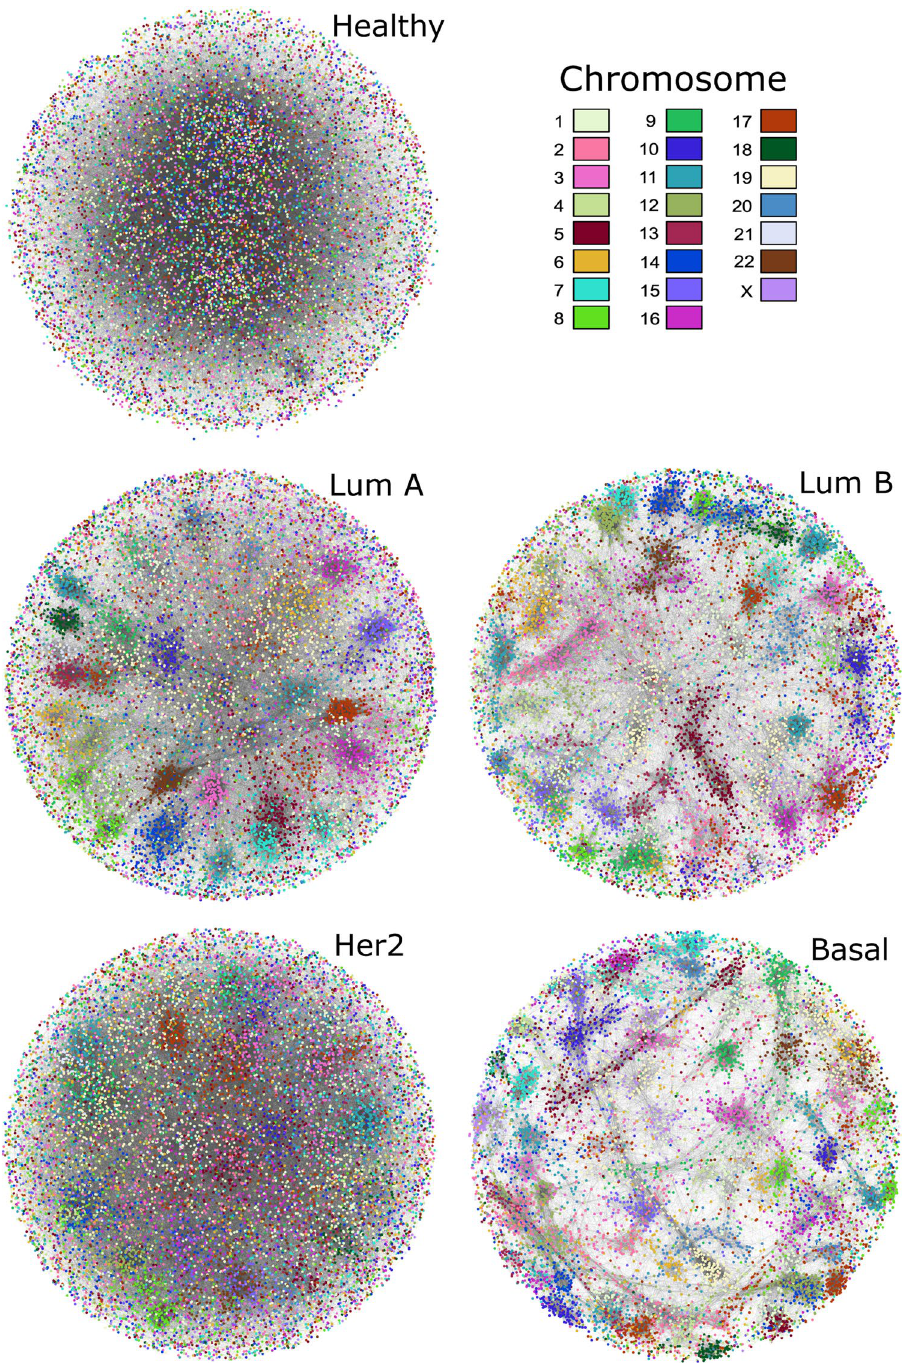
Figure 1. Network structure of the top-100,000 highest interactions. Starting from the full transcriptomes for the 4 breast cancer subtypes and the healthy breast tissue as measured by RNA Sequencing, mutual information calculations were used to infer the 5 associated networks. Once statistical significance was determined and thresholding was performed, networks of comparable size (with n = 100,000 interactions, ordered by statistical significance) were built. For this visualization, genes were colored according to the chromosome they belonged to. Network visualizations were performed using the spring embedded algorithm. In cancer networks, clusters of genes from the same chromosome (same color) are